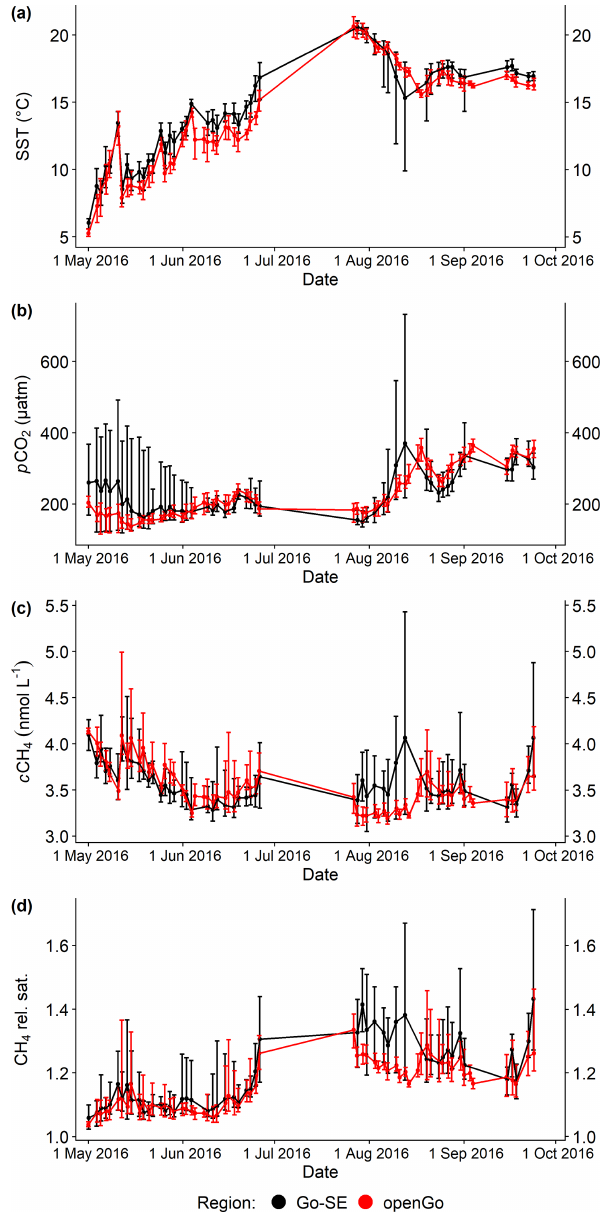
Figure B4. (a) Sea surface temperature, (b) CO 2 partial pressure, (c) CH 4 concentration, and (d) relative CH 4 saturation within the Go-SE (black) and openGo (red) boxes from 1 May to 23 Septem- ber 2016. Points and lines represent mean values per sub-transect; error bars denote maximum and minimum, respectively. The effect of upwelling is very prominent in August 2016 (compare Fig. 4), when the Go-SE box features decreased SST and increased p CO 2 , c CH 4 , and relative CH 4 saturation values compared to the openGo box, which is not affected by